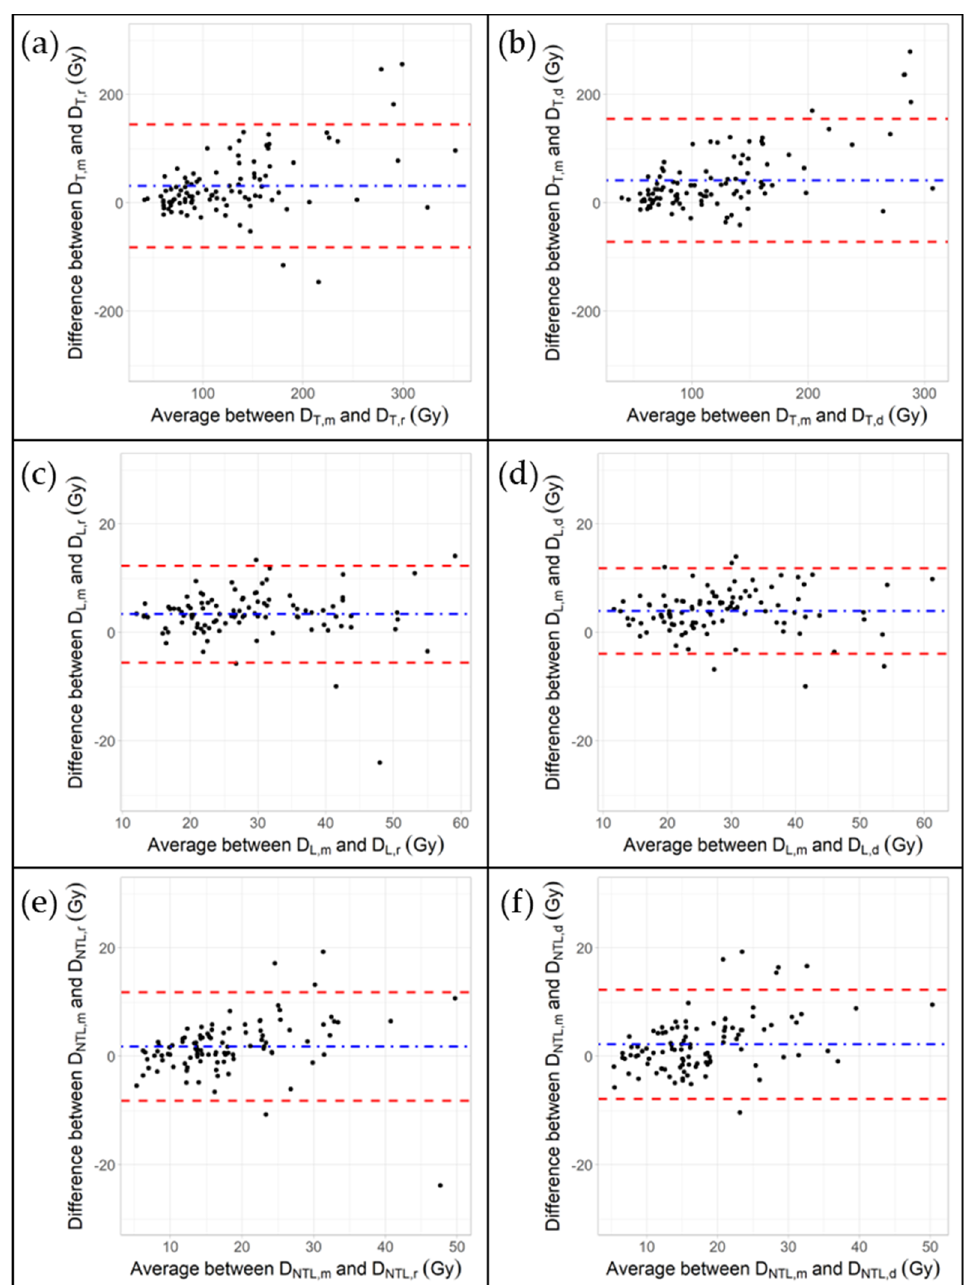
Figure 3. Bland–Altman plots for tumor (i.e., panels ( a , b )), whole liver (i.e., panels ( c , d )) and NTL (i.e., panels ( e , f )) mean absorbed doses according to the contouring approach.